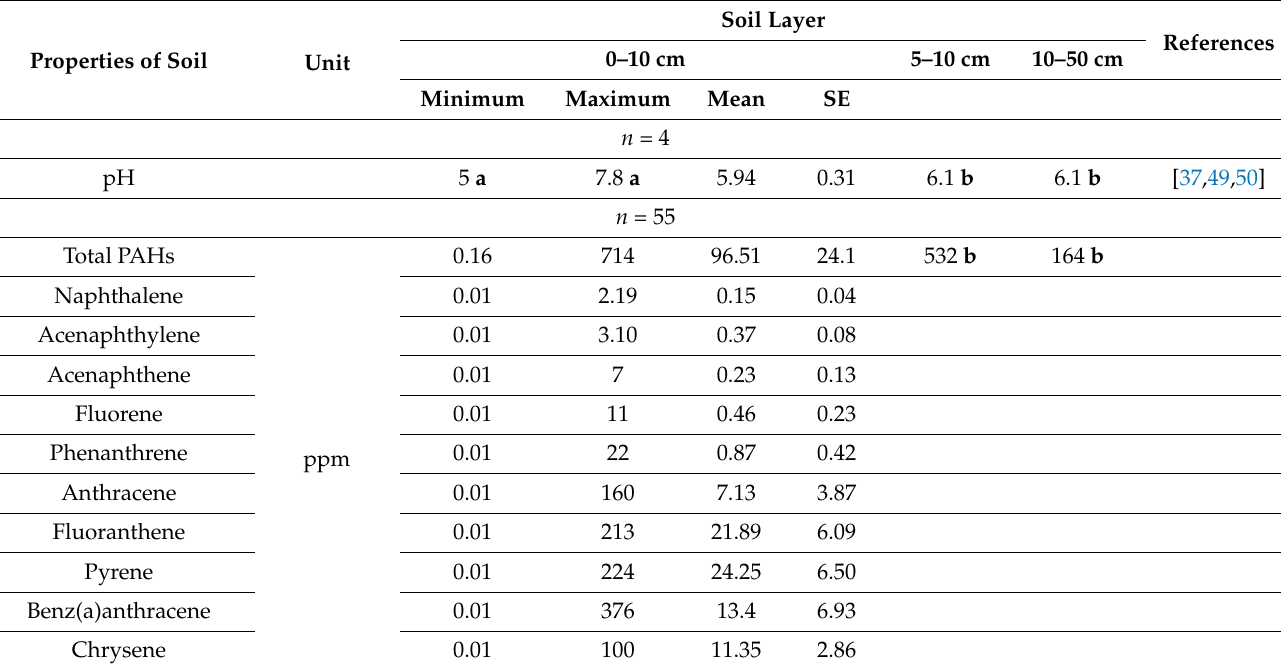
Figure 1. Map of the study area Somerharju. Table 1. Description of soil pollutants (total PAHs, 16 USEPA priority PAHs, TPH (C10–C21, C22–C40, and C10–C40)), nutrients, and soil